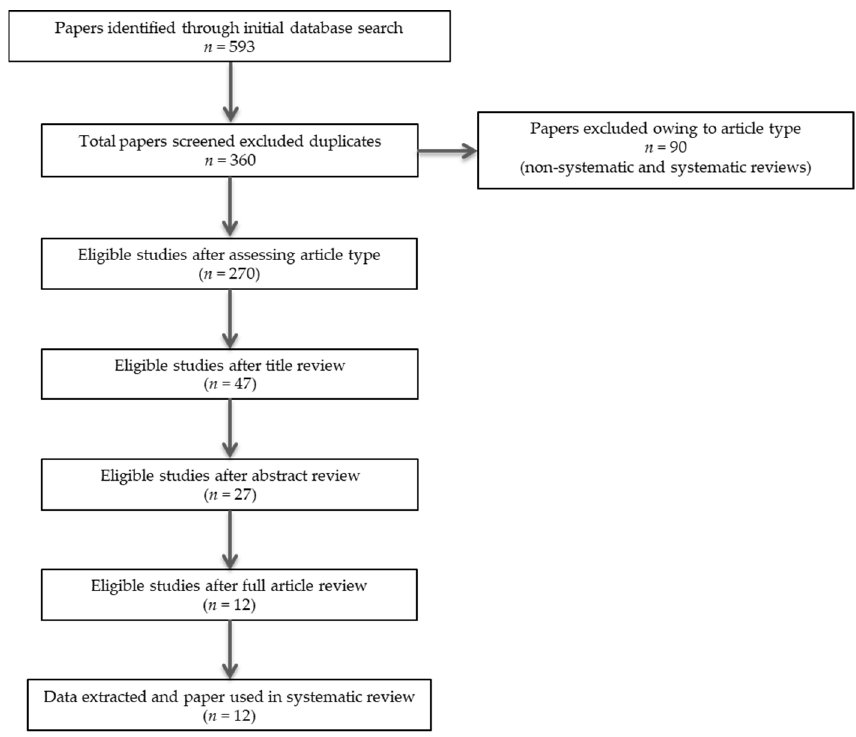
Figure 1. PRISMA flowchart of search strategy for systematic review.